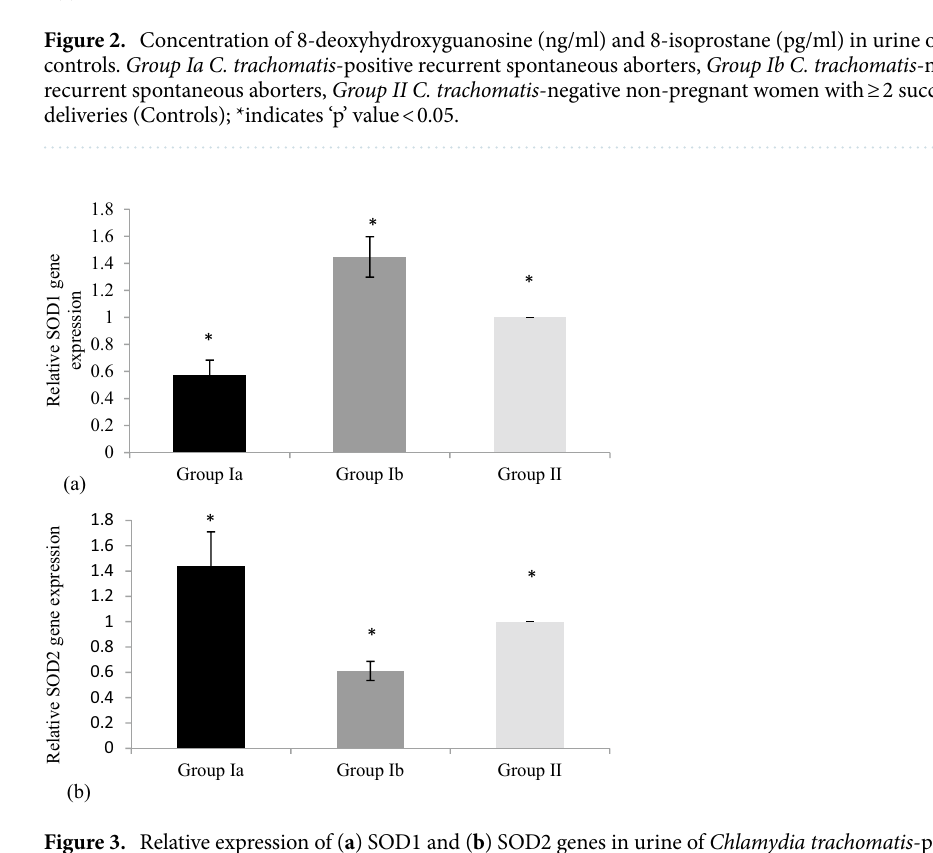
Figure 3. Relative expression of ( a ) SOD1 and ( b ) SOD2 genes in urine of Chlamydia trachomatis -positive recurrent spontaneous aborters. Group Ia C. trachomatis -positive recurrent spontaneous aborters, Group Ib C. trachomatis -negative recurrent spontaneous aborters, Group II C. trachomatis -negative non-pregnant women with > 2 successful deliveries